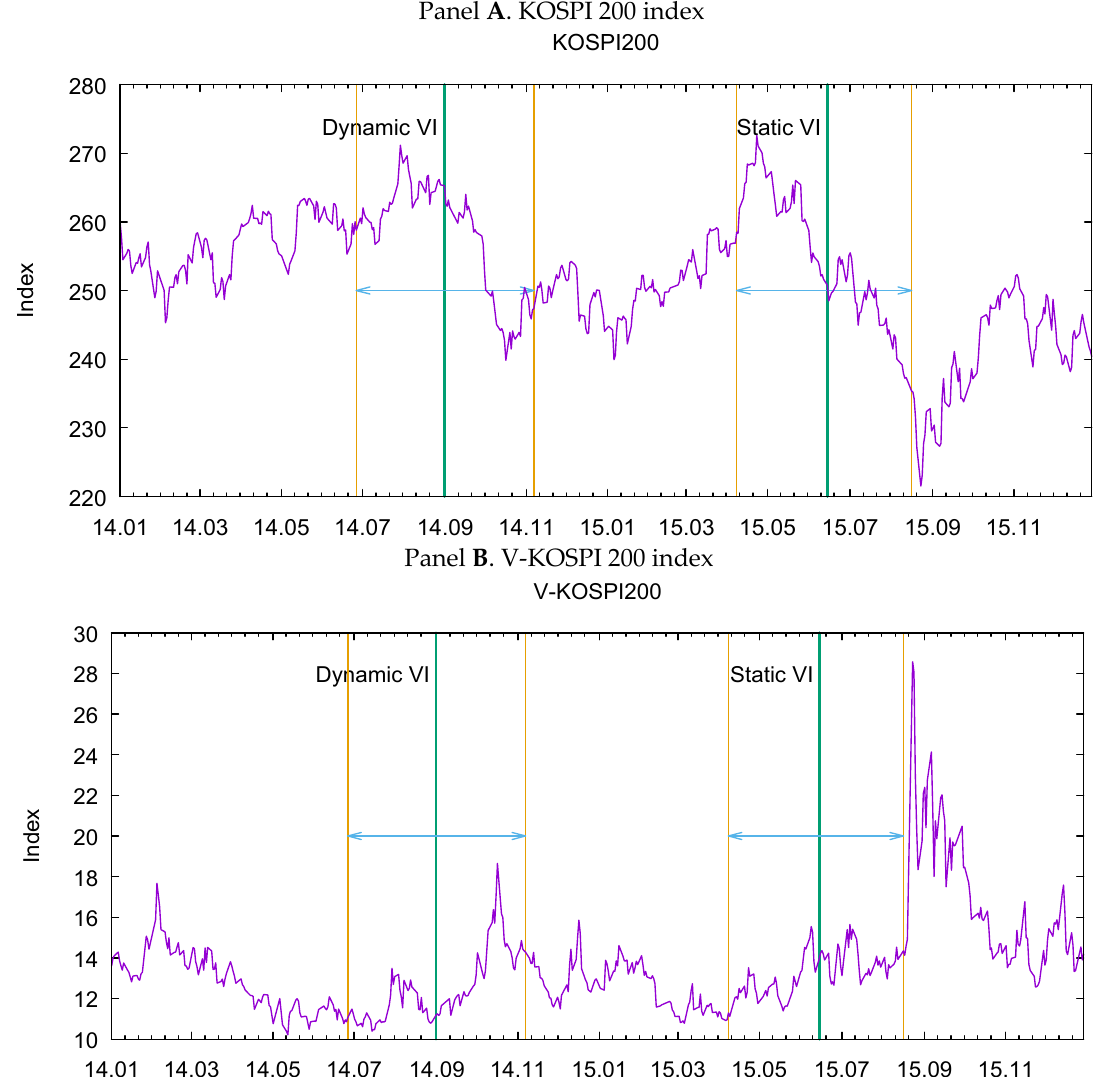
Figure 2. Time-series of the KOSPI 200 index and the V-KOSPI 200 index. This figure depicts the stock market movement from January 2014 to January 2016. Panel ( A ) and Panel ( B ) show the time-series of a market index (KOSPI200) and a market volatility index (V-KOSPI200), respectively. The horizontal axis indicates the date (yy.mm) and the vertical axis indicates the index value.